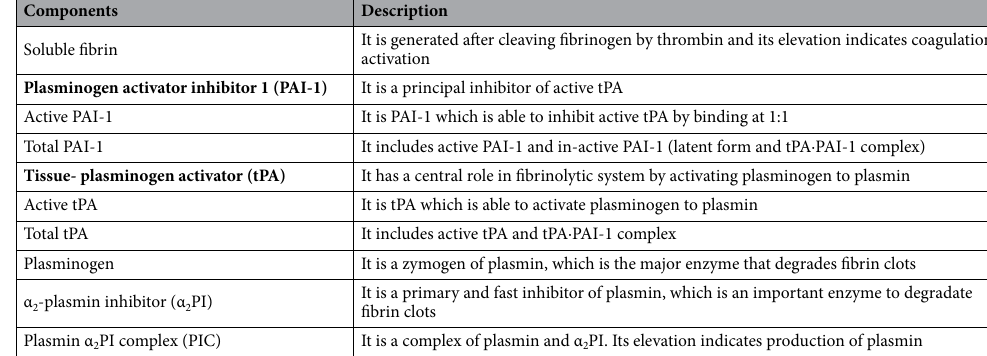
Table 1. Components of coagulation and fibrinolytic system measured in the present